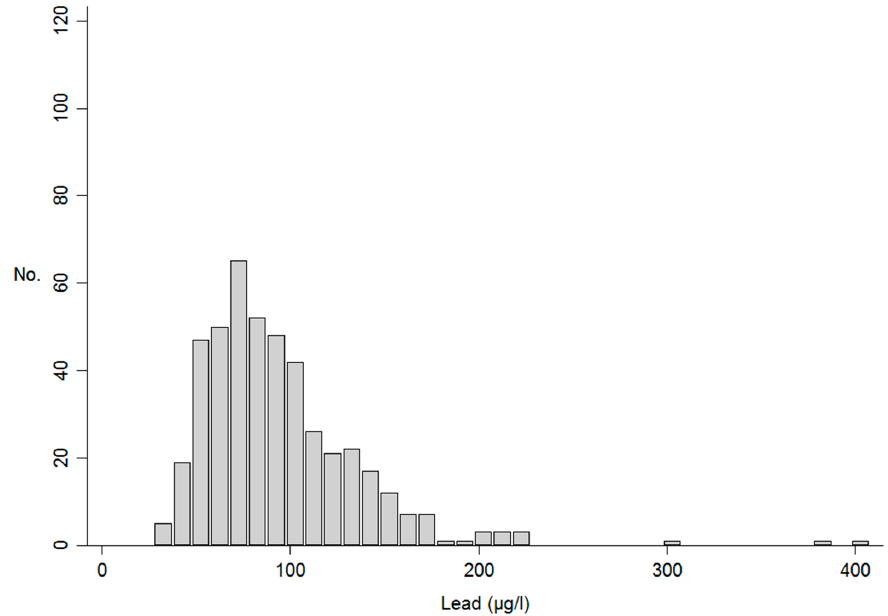
Figure 1. Erythrocyte lead levels ( μ g/L) among the 454 subjects included in the